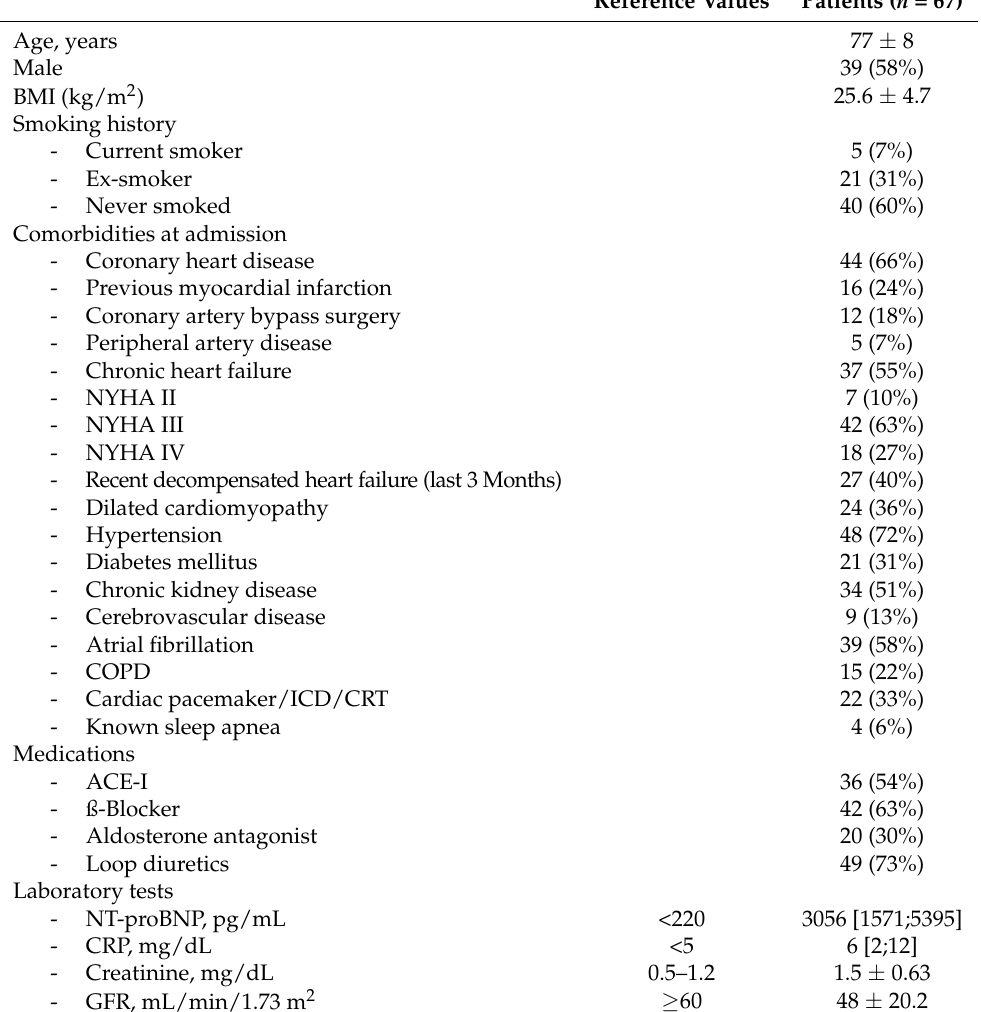
Table 1. Patient clinical and demographic data at